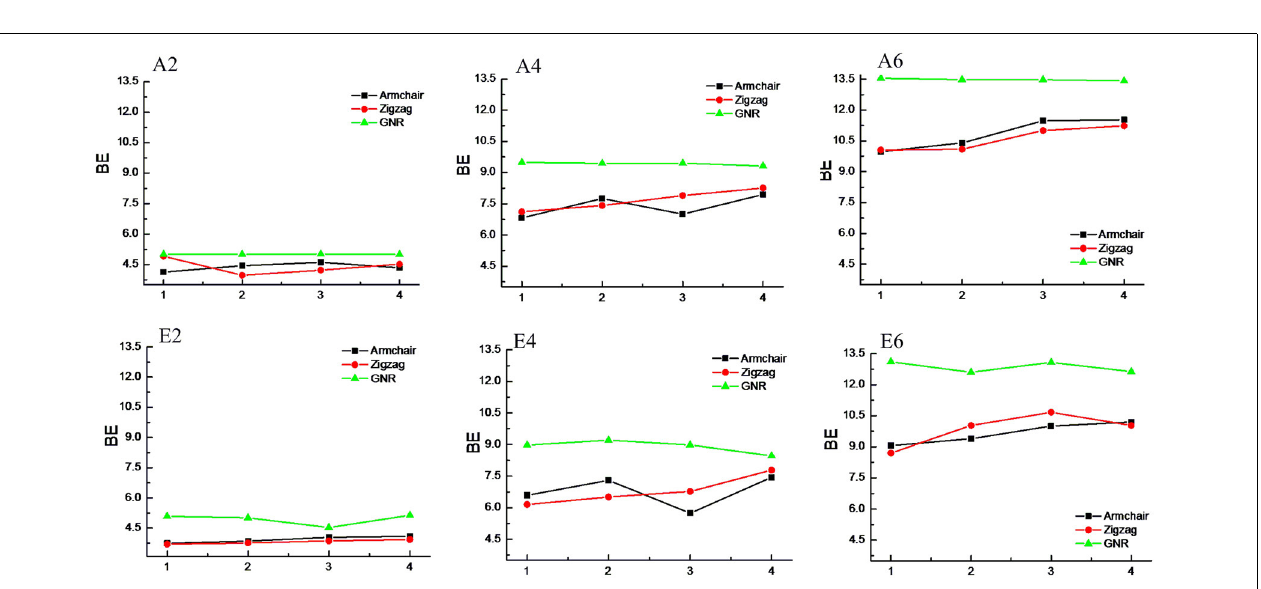
FIGURE 7 | Binding energy of cyclic vs. acyclic unsaturated hydrocarbons. (A) 1,3 butadiene vs. cyclobutadiene and (B) 1,3,5 hexatriene vs. benzene.